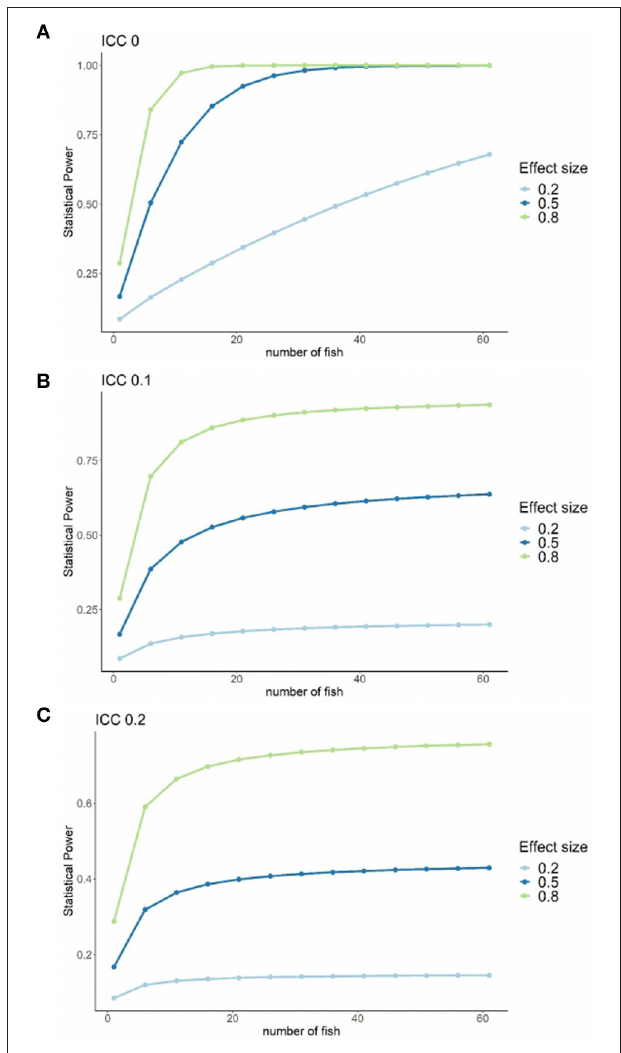
FIGURE 5 | Graph of the statistical power vs. number of fish sampled for three treatment effect sizes (small = 0.2, medium = 0.5 and large = 0.8). (A–C) Three ICC values, 0.1, 0.2, and 0.2, respectively. Data for this study experimental units, i.e., nine fish tanks with three tanks per